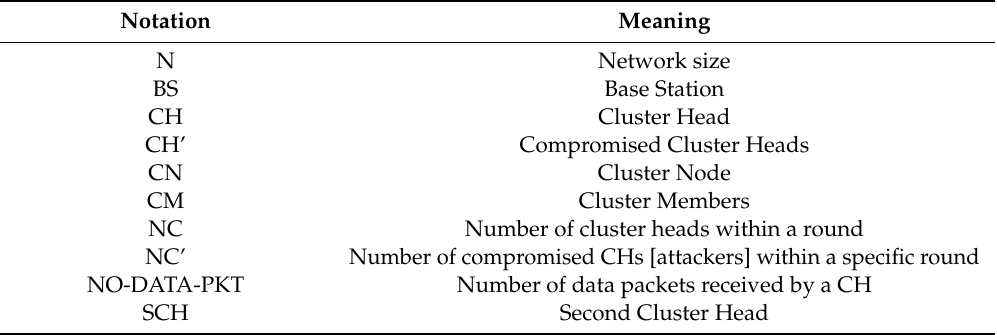
Table 7. Equations’ notations and their